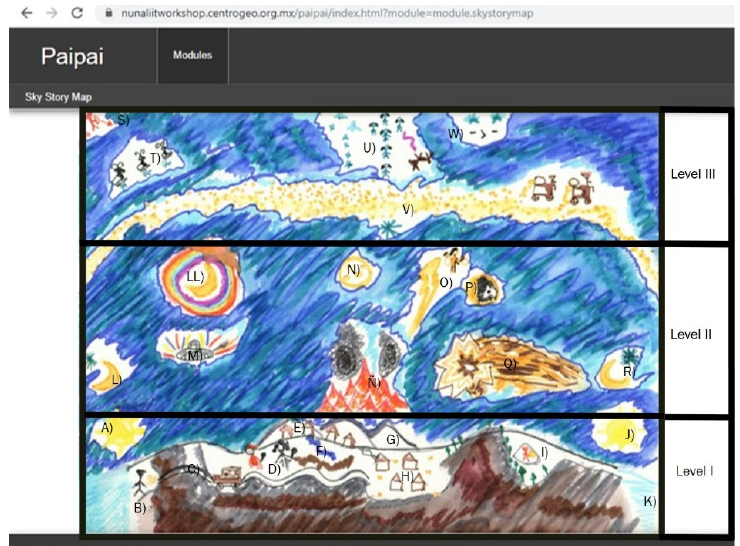
Figure 1. Pa Ipai sky cybercartographic atlas.